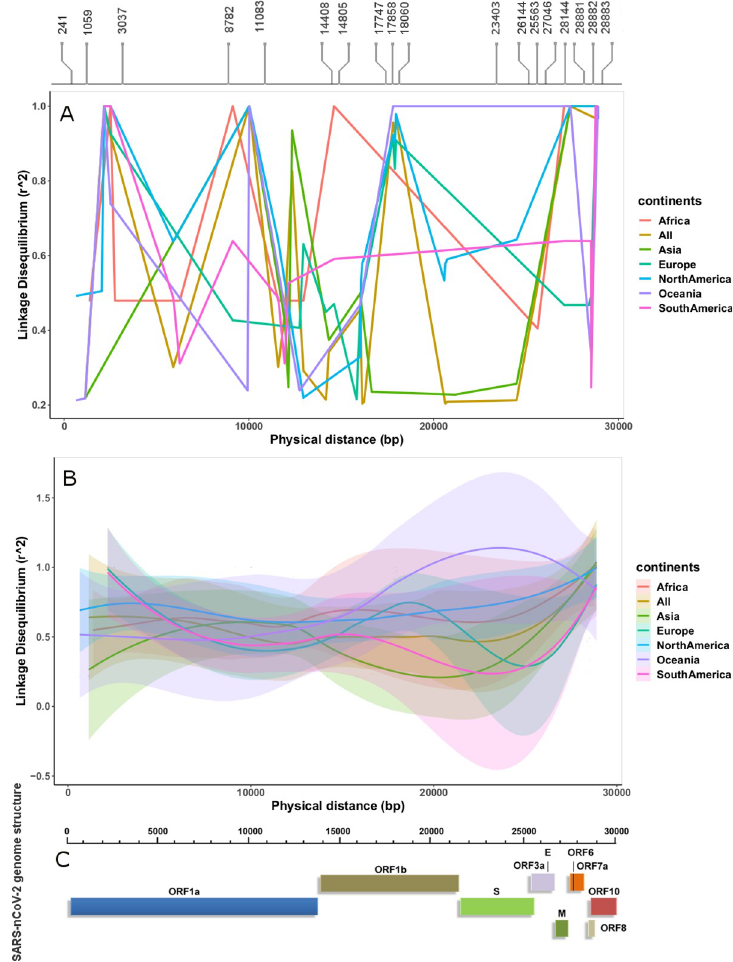
Fig 5. Correlation between LD and physical distance across continental SARS-CoV-2 genomes. (A) Upward peaks show strong LD and downward peaks show weak LD. North America and Oceania showed strong LD in the region overlapping the S protein. Strong LD among variants suggested that these de novo mutations were not broken by recombination events, (B) Smooth lines showed clear differences in LD over physical distance across continental datasets, (C) The genomic structure of SARS-CoV-2 is